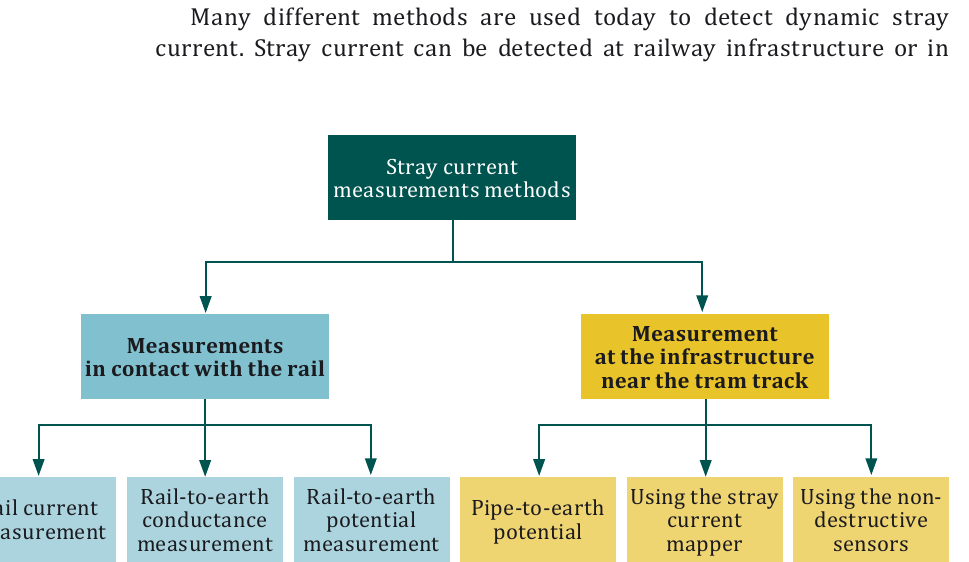
Figure 4. Stray current detection